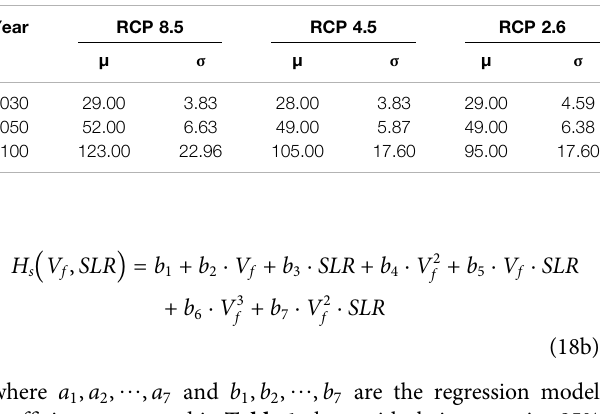
TABLE 2 | Parameters of the normal distribution models for sea-level rise projections in Galveston,